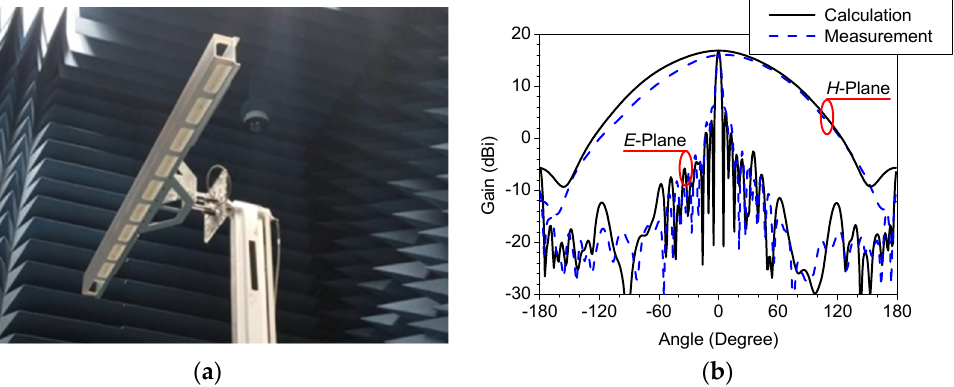
Figure 4. Measurement of the fabricated 16 × 1 antenna subarray: ( a ) measurement environment and ( b ) far-field radiation pattern in both the E- and H-planes.